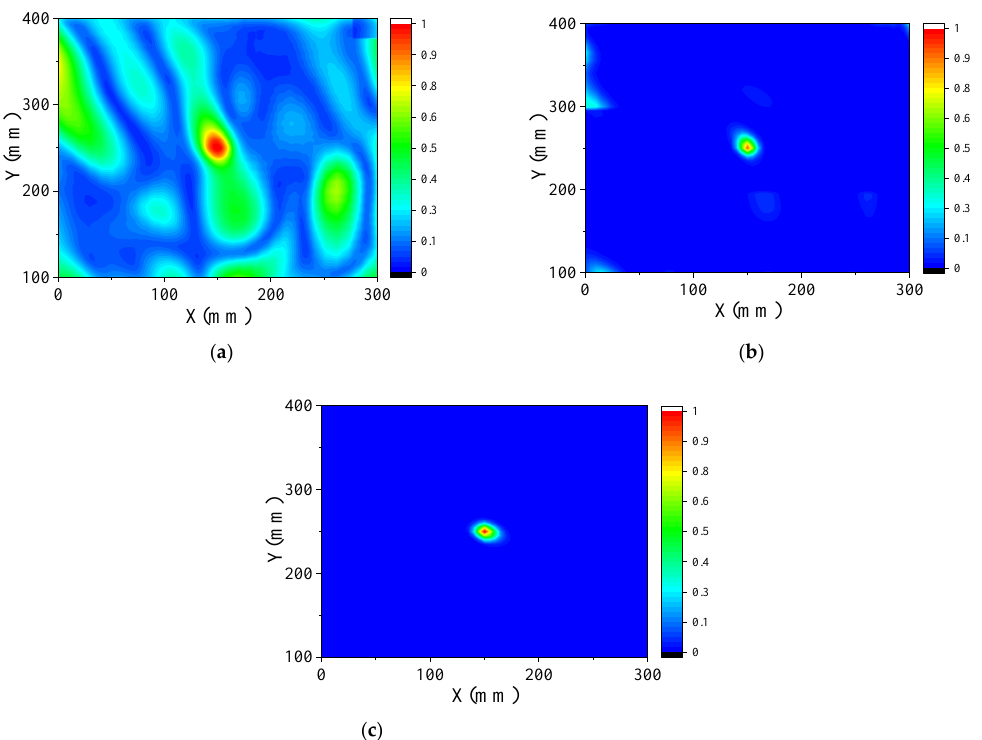
Figure 5. The imaging results of UWB-CS and SI-CS for a single PIM source: ( a ) UWB-CS and ( b ) SI-CS with δ = 0.8 and µ = 0.5 and ( c ) SI-CS with δ = 0.8 and µ =